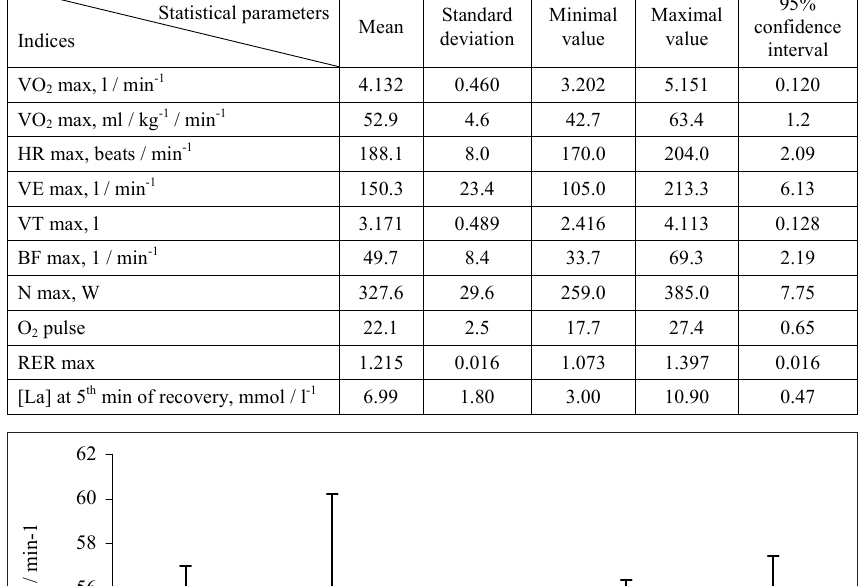
Fig. 2. The comparison of VO values (means and SD) among academic and women subjects